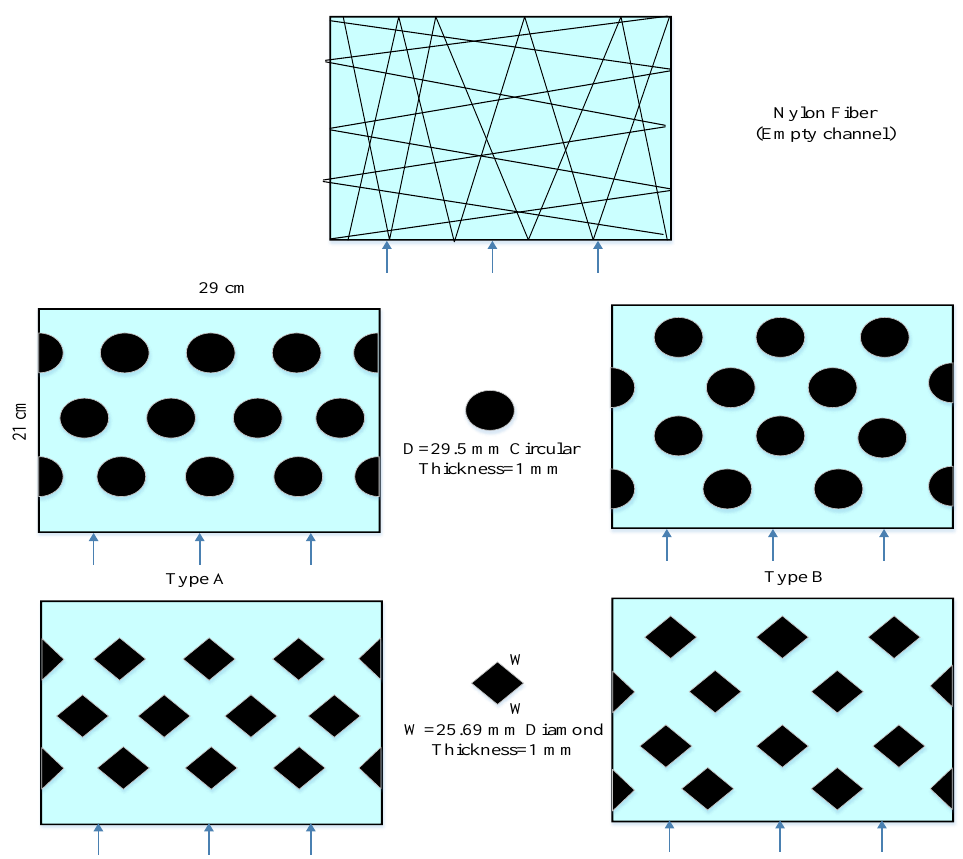
Figure 7. A schematic diagram of three flow channel types.